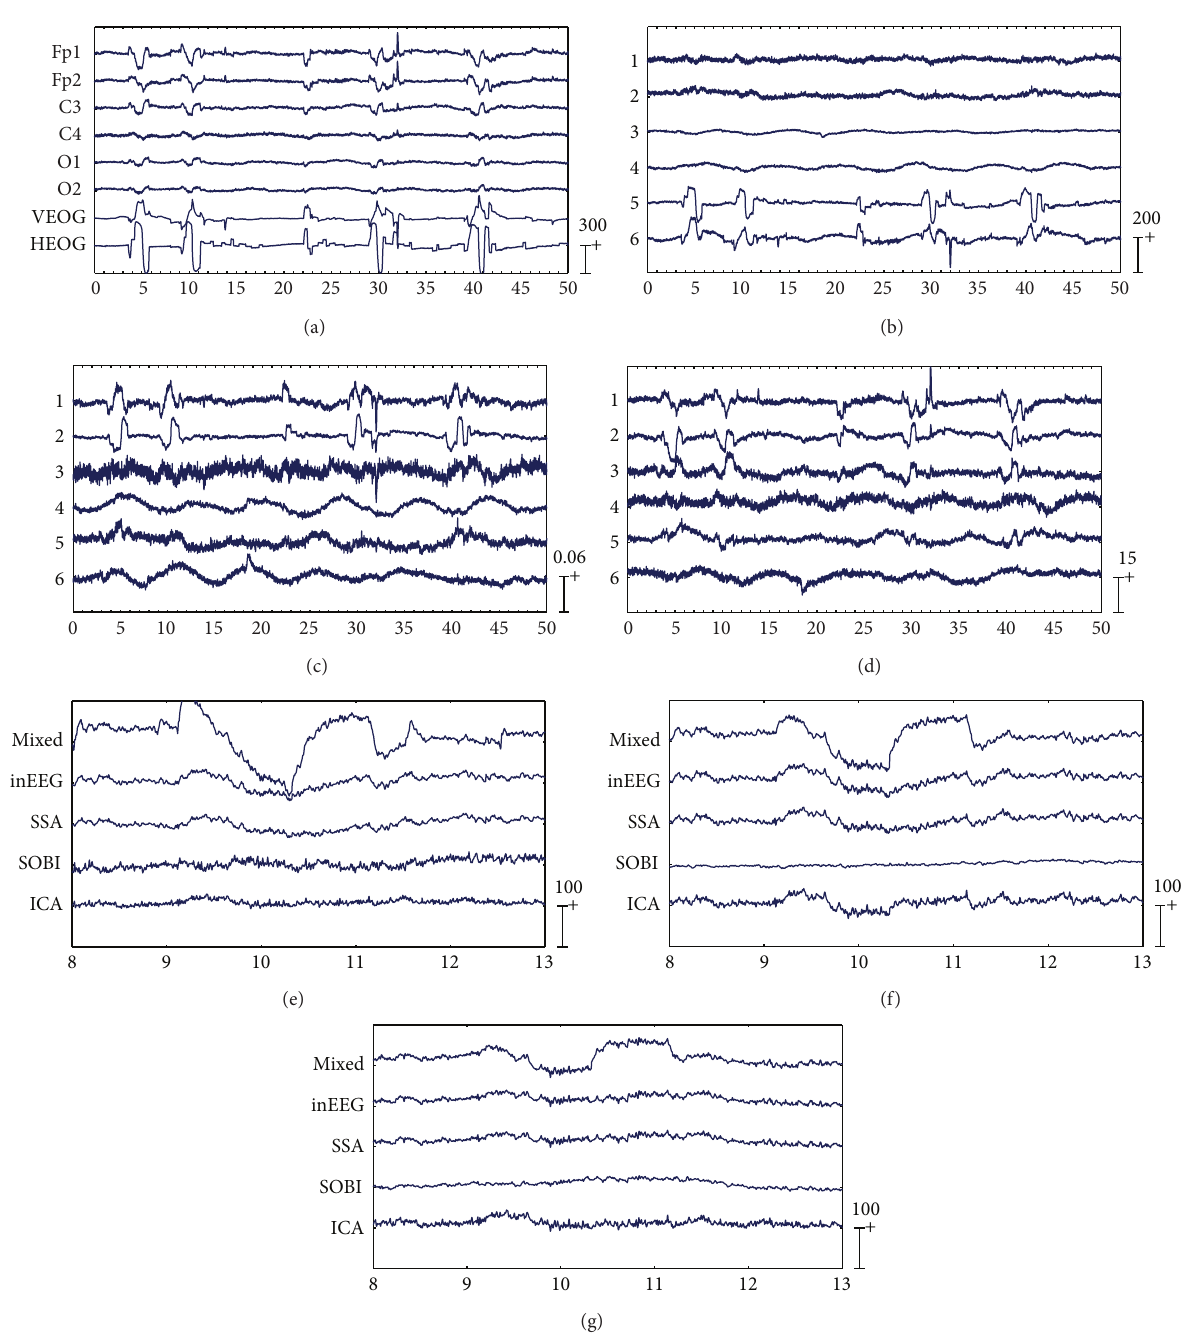
Figure3:ResultsofEOGartifactremovalonanexampleEEGdatasetfromthe20artificiallycontaminatedones.Theartificiallycontaminated EEG data with eye movement and blink artifacts are shown in the first six EEG channels of (a) and the corresponding EOG signals used in the mixing procedure are presented in the last two channels of (a). Components separated by SSA, SOBI, and ICA are shown in (b), (c), and (d), respectively. The zoomed mixed, precontaminated EEG, and corrected EEG signals by each method on channel Fp1, C3, and O1 are depicted in (e), (f), and (g),